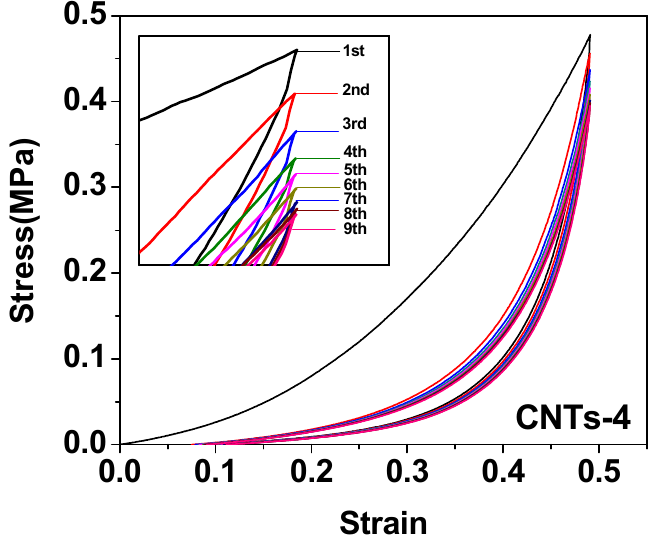
Figure 8. General shape of nine consecutive compressive loading-unloading cycles is given for